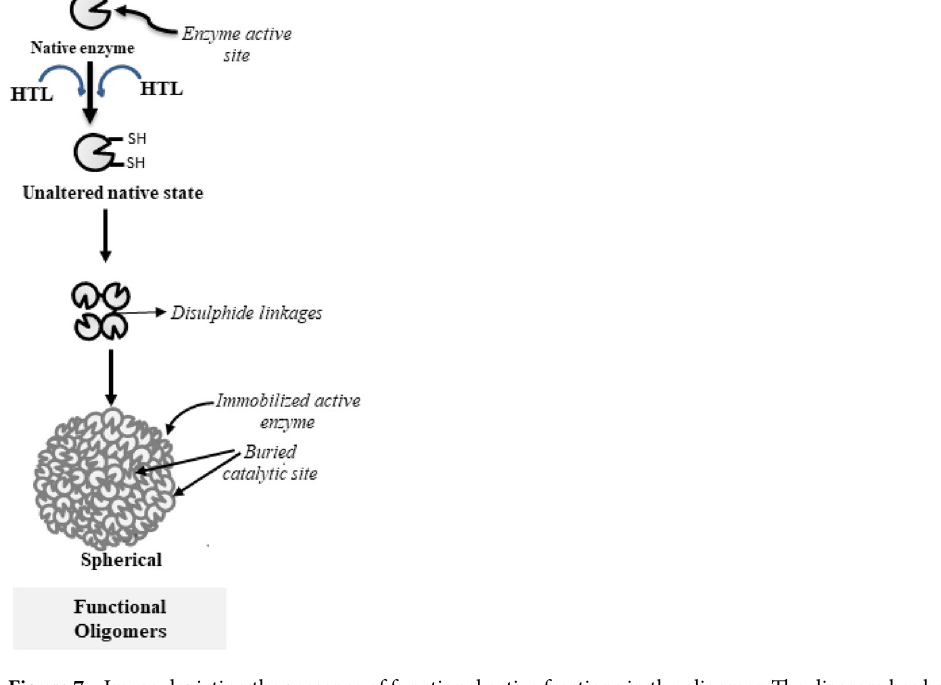
Figure 7. Image depicting the presence of functional active fractions in the oligomer. The diagram has been shown as 2D.